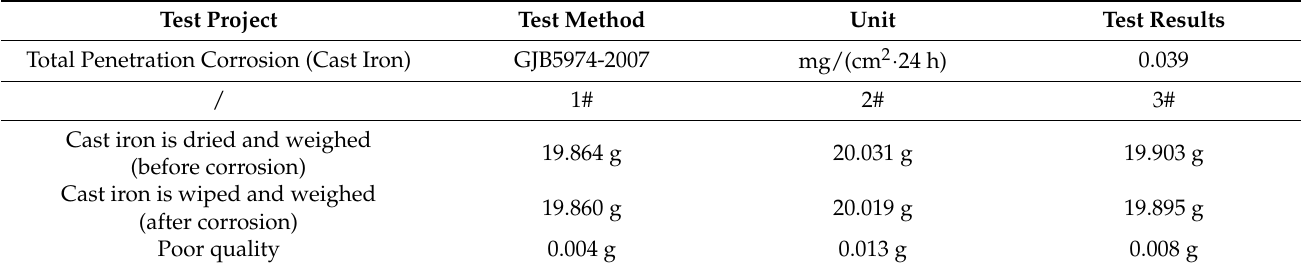
Table 2. Metal corrosion